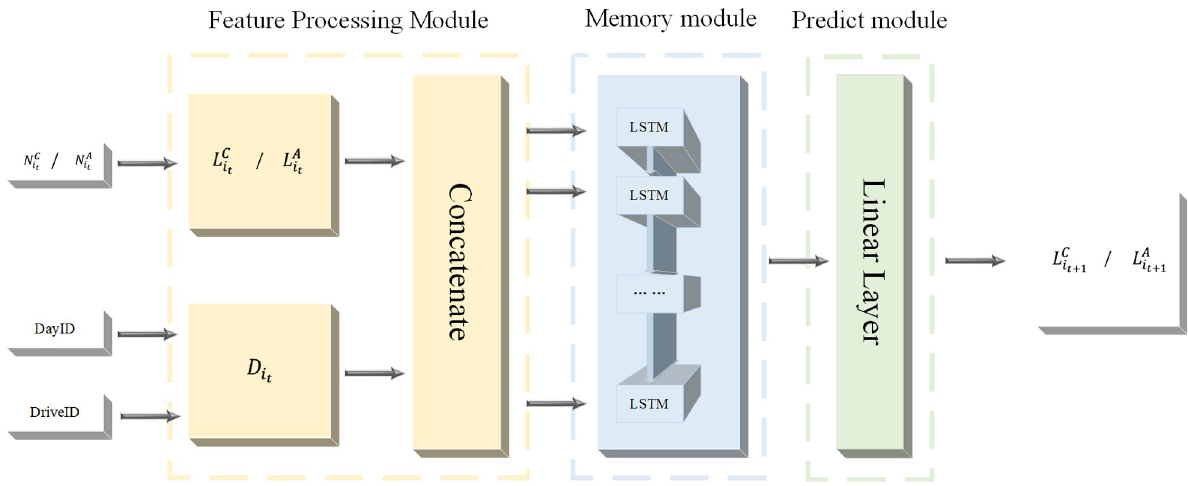
Fig 1. Driving behavior risk prediction neural-network (DBRPNN) architecture.